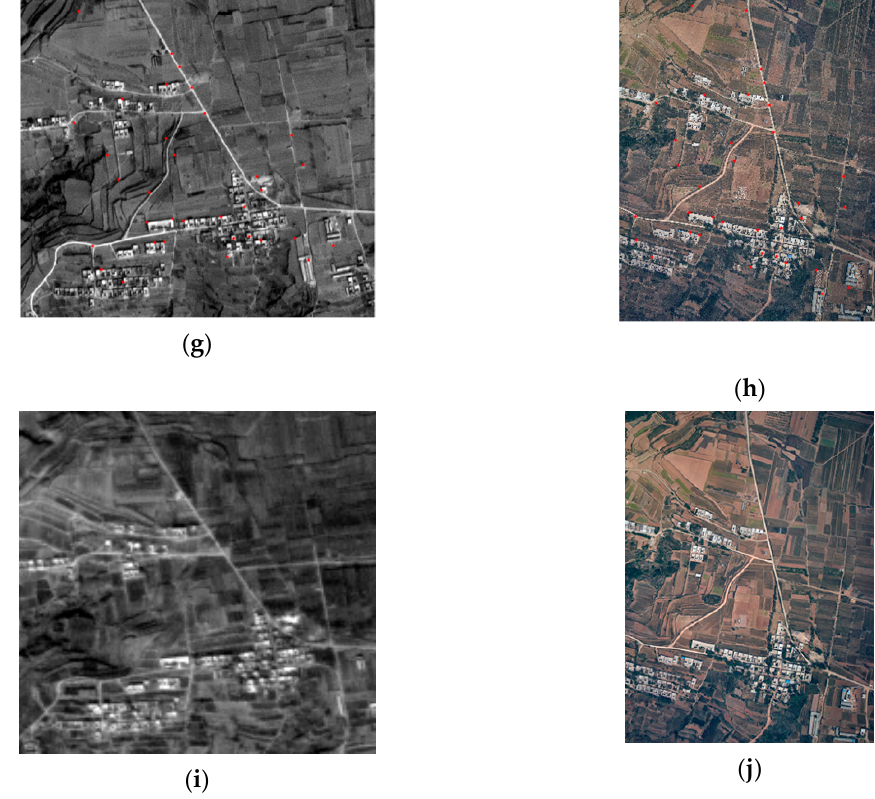
Figure 4. Image pairs to be registered. The specific parameters of Figure 4a to 4j are listed in Table 1. Red points in the images show the spatial distribution of extracted control points (CPs) using Automatic Point Measurement (APM).